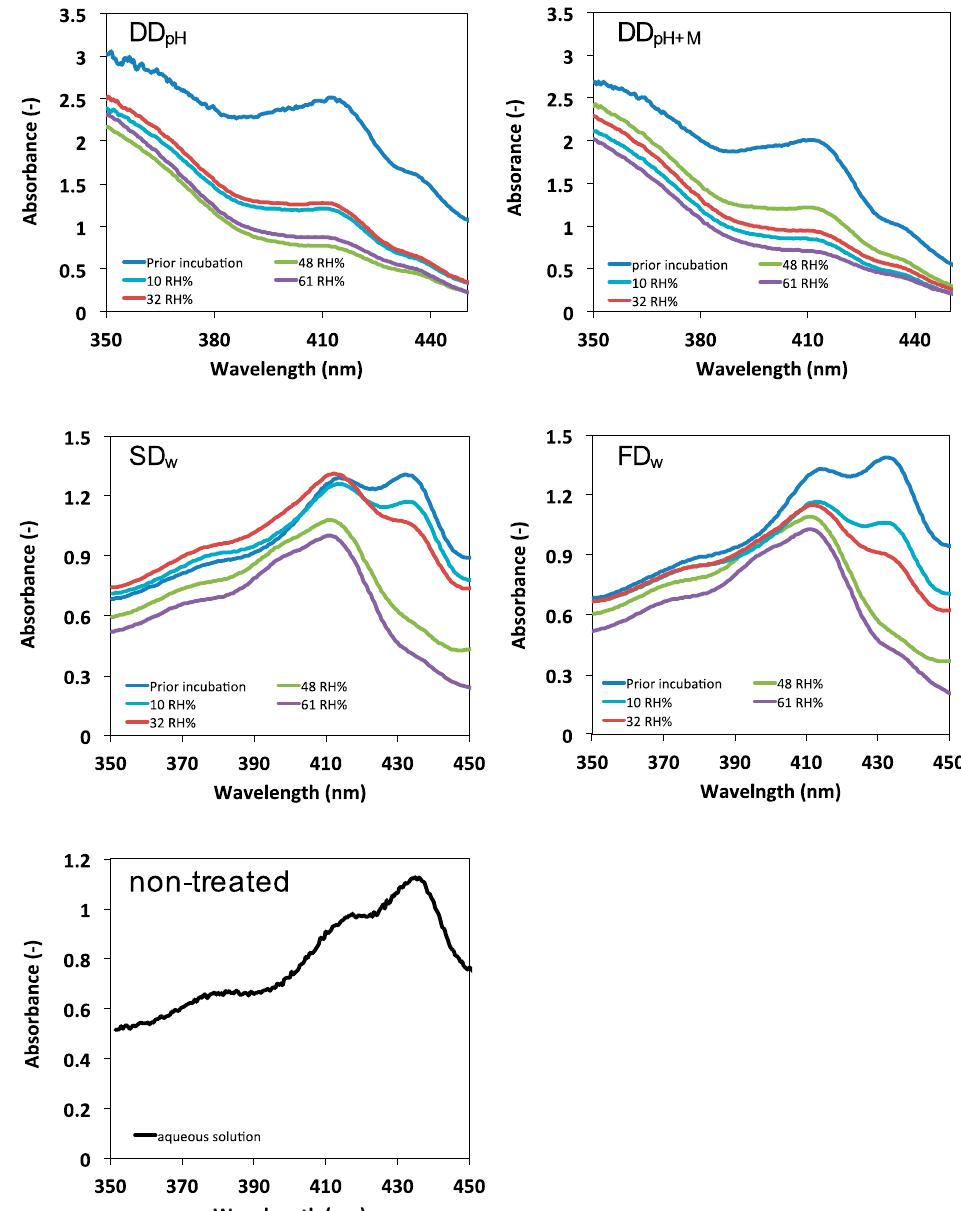
Figure 4. Absorption spectra for thylakoid powders produced in different ways after 8 months storage in controlled atmosphere with different relative humidity. Non-treated thylakoids in aqueous solution is provided for comparison. Due to limitations in the method, the absolute values cannot be compared. DD pH = drum-dried powder produced by the pH method, DD pH+M = drum-dried powder produced by the pH method with addition of maltodextrin, SD w = spray-dried powder produced by the water method, FD w = freeze-dried powder produced by the water method.